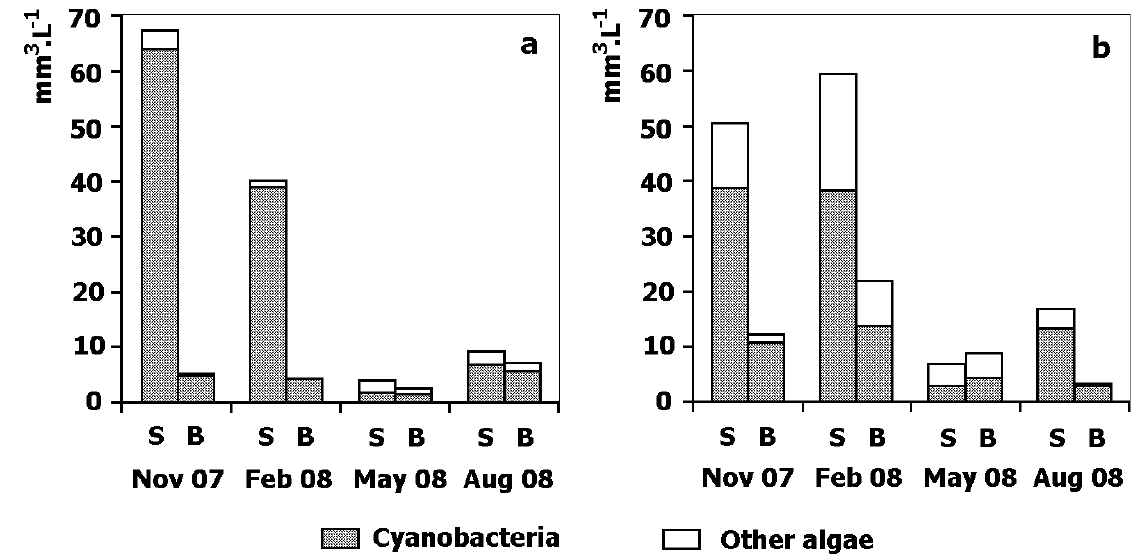
Fig. 3 – Variation in biomass of cyanobacteria and other algae (mm 3 .L − 1 ) in the Arcoverde (a) and Pedra (b) reservoirs, Pernambuco State, Brazil; S = subsurface; B = bottom.